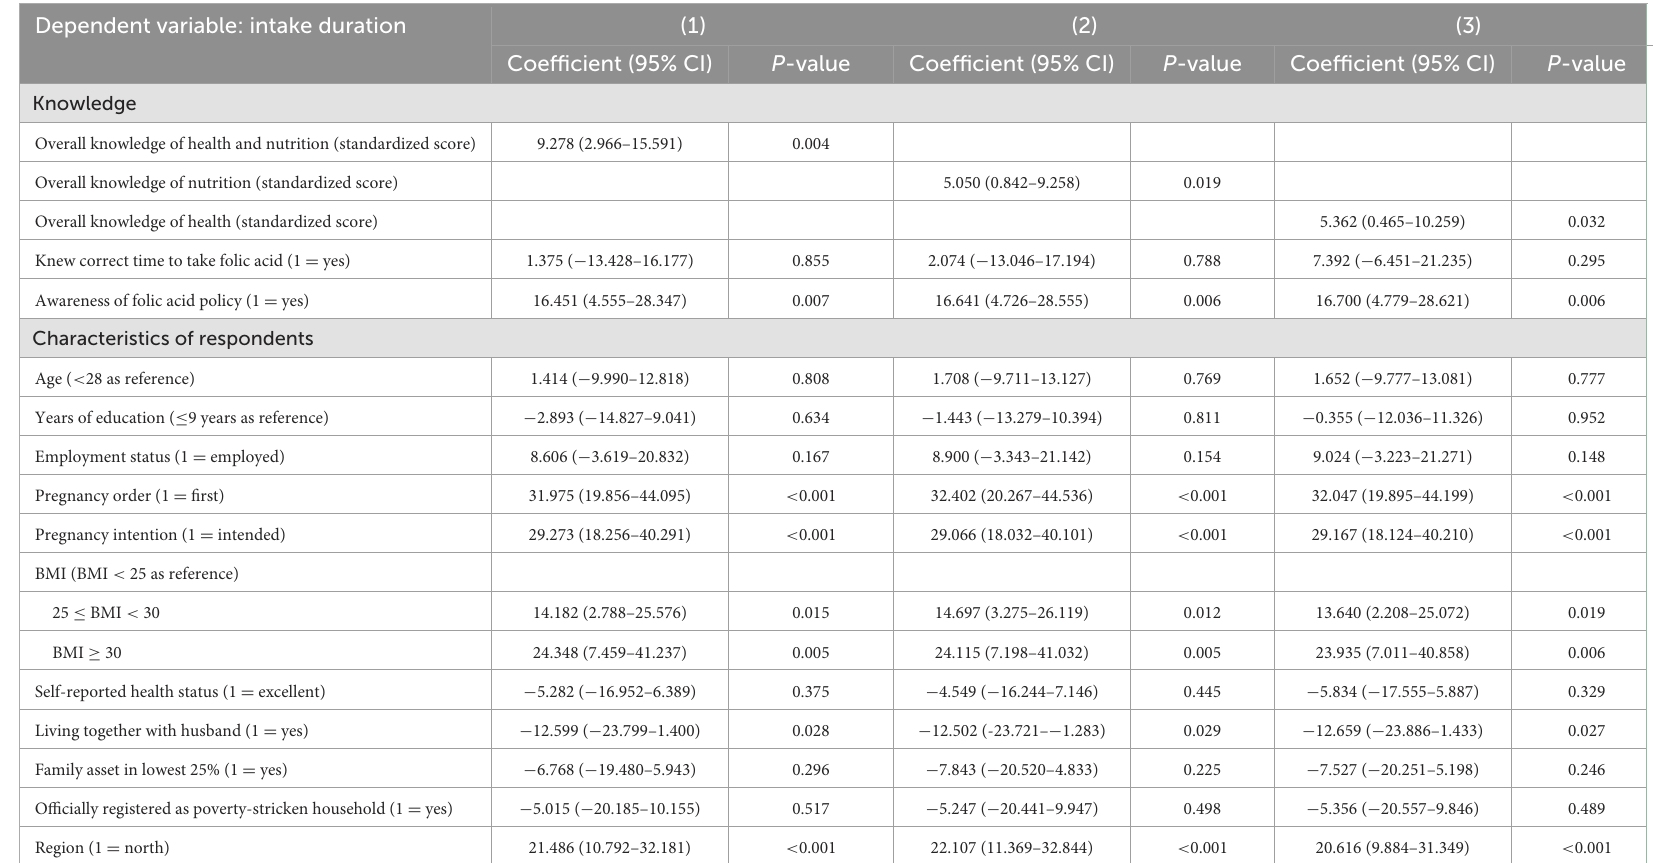
TABLE 5 Results of multiple linear regression analyses of variables related to the duration of